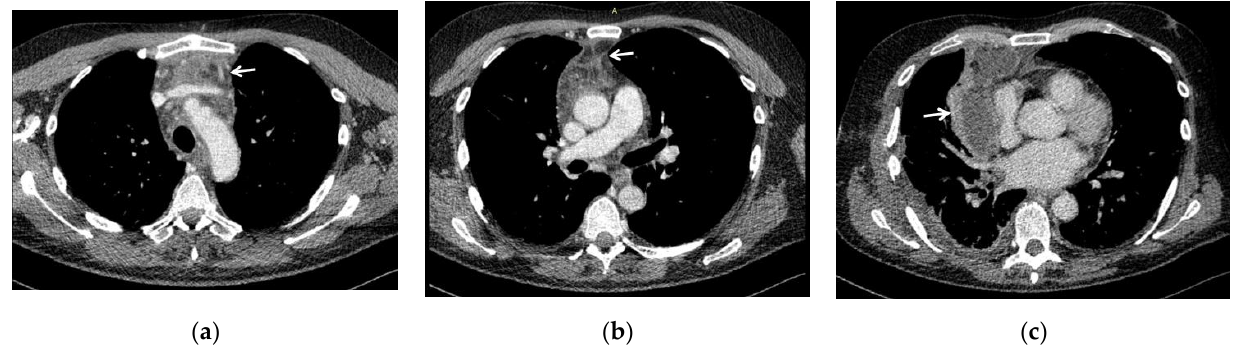
Figure 1. CT scans showing the spread of infection of DNM in three of our patients, evaluated according to Endo’s classification of DNM [7,8]: ( a ) type I (DNM localized in the upper mediastinum above the tracheal bifurcation); ( b ) type IIA (DNM extends to the lower anterior mediastinum, below the tracheal bifurcation); ( c ) type IIB (DNM extends to the anterior and lower posterior mediastinum), with associated right pleural effusion. White arrows indicate the mediastinal involvement.